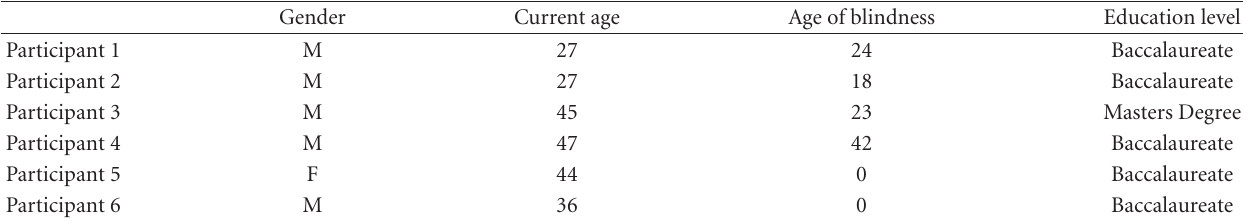
Table 1: Gender, current age, age of onset of blindness, and education level of the participants.